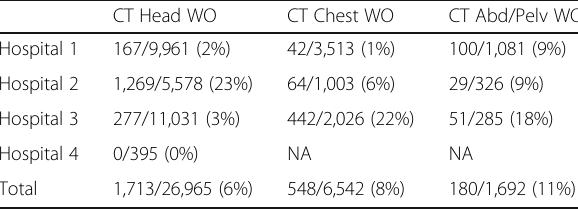
Data in parentheses are percentages. NA Not